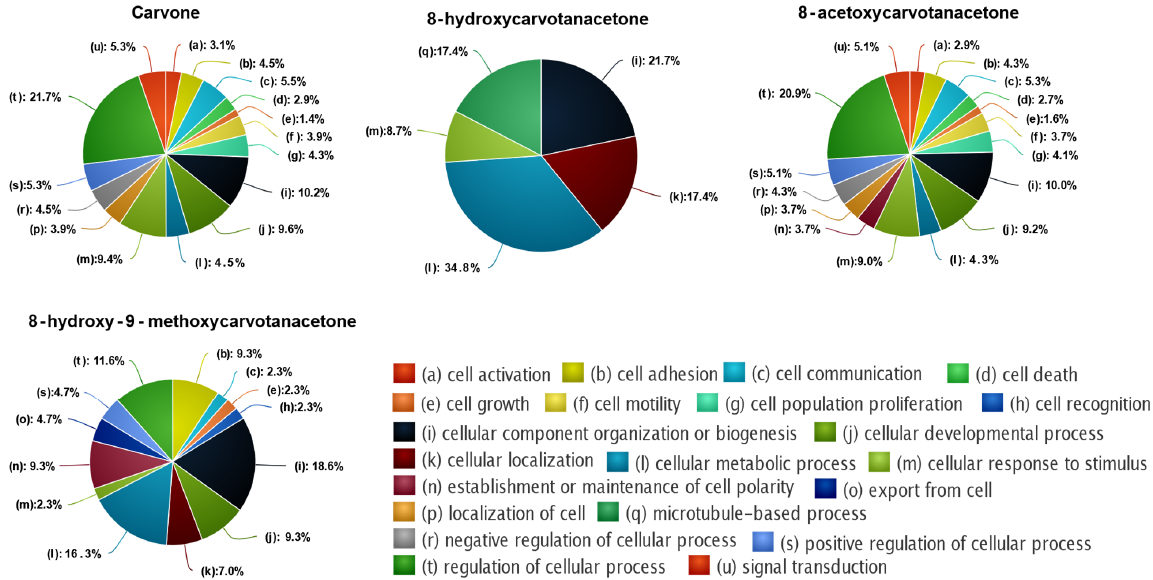
Figure 5. Functional enrichment analysis of the biological processes predicted to be affected by the 4 structures tested, according to the DTI prediction model.